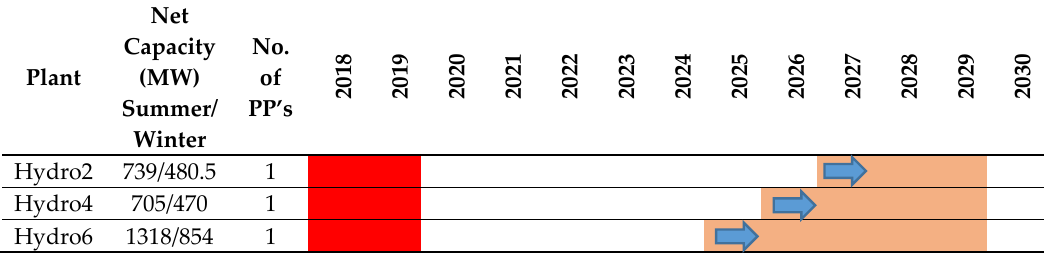
Table A1. Details of the Plants Installation under Capacity Expansion: Normal GDP Reference Case.